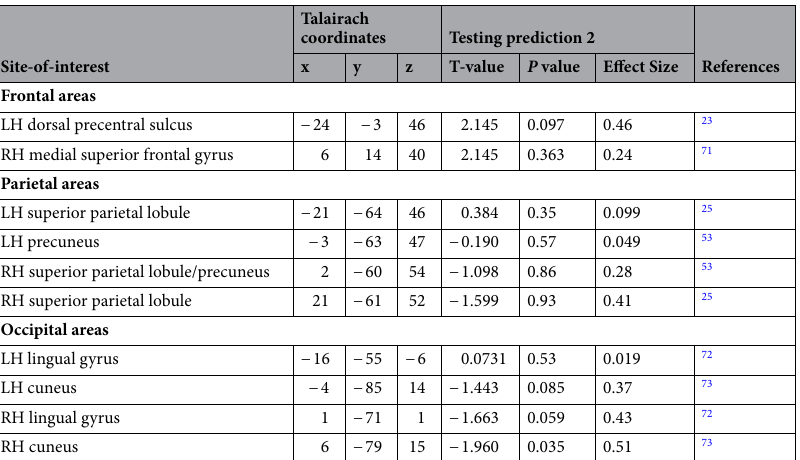
Table 1. Regions, Talairach coordinates, and statistical results for tests of Prediction 2 (t-value, p value, and effect size) for parietal and occipital sites-of-interest from the Visual/Oculomotor Updating